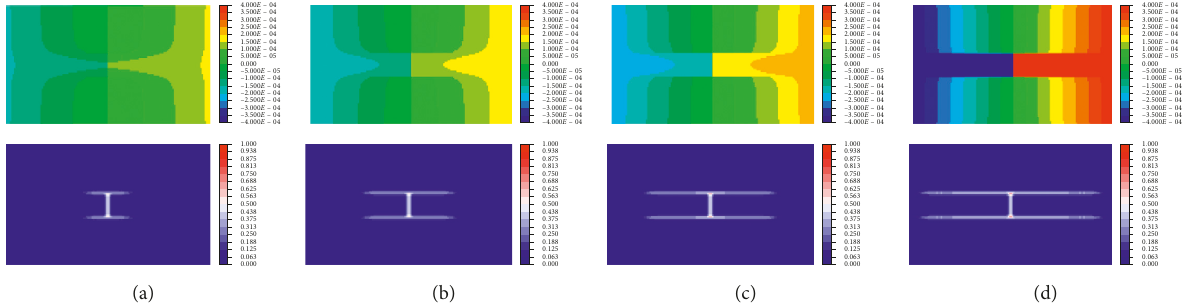
Figure 17: Progressive failure process of B-0-0 specimen (damage (0-1)). (a) t